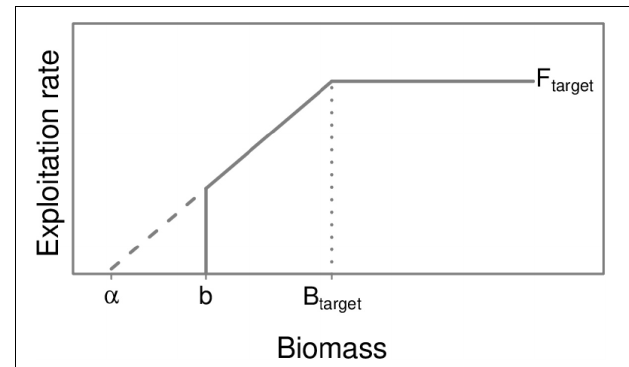
FIGURE 3 | Schematic of the harvest control rule used to determine the acceptable biological catch of groundfish subject to the ecosystem harvest cap. The target biomass ( B target ) and target exploitation rate ( F target ) are the Ecopath-based biomass and exploitation rate. α is the intercept to the sloped harvest control rule where fishing mortality, and thus ABC, would be equal to zero. We use a modified harvest control rule that sets fishing mortality equal to zero when the simulated stock biomass drops below a minimum threshold of 0.2 B target (b).